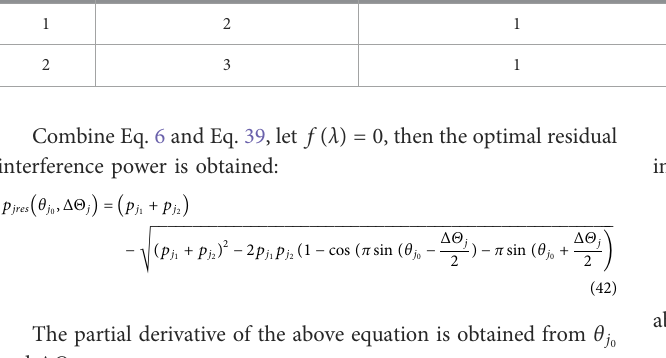
TABLE 2 Typical interference con fi guration. con fi g Number of interferences Total power of